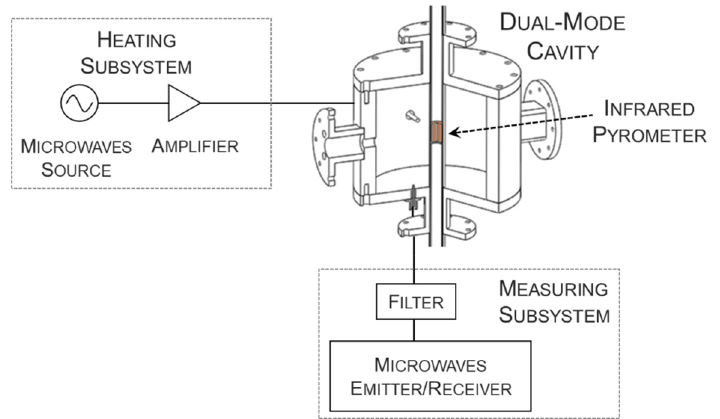
Figure 1. Schematic view of experimental set-up with the microwave dual system for heating and measuring the dielectric properties of samples during the carbothermic reduction process. The sample is placed inside a quartz holder and located in the center of the cylindrical microwave cavity.